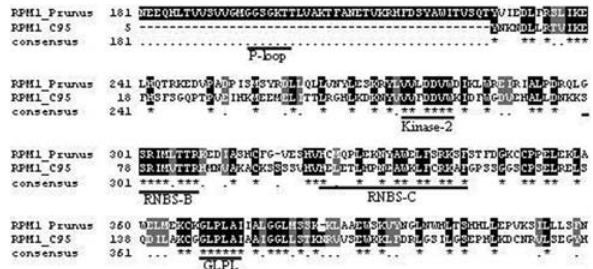
Figure 4 - Alignment (ClustalW) of the CitEST contig C95 and RPM1 from Prunus persica (GenBank Accession Number AAT09451). Amino acids boxed in black and (*) are invariant, whereas residues shaded in grey and (.) are conserved in > 75% of the sequences. Domains characteristic are